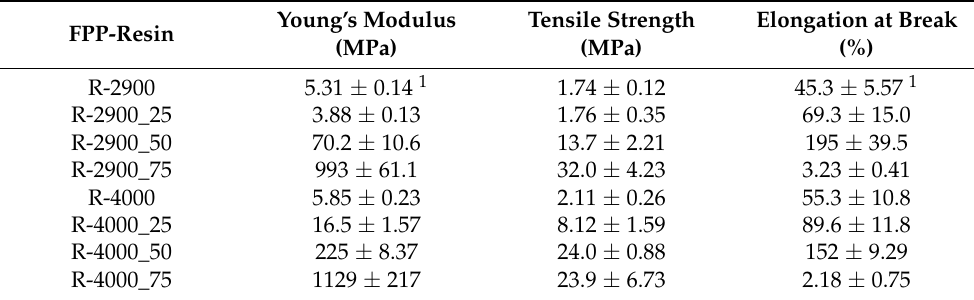
Table 3. Tensile properties of polymers produced with resins suitable for FPP. Young’s FPP-Resin